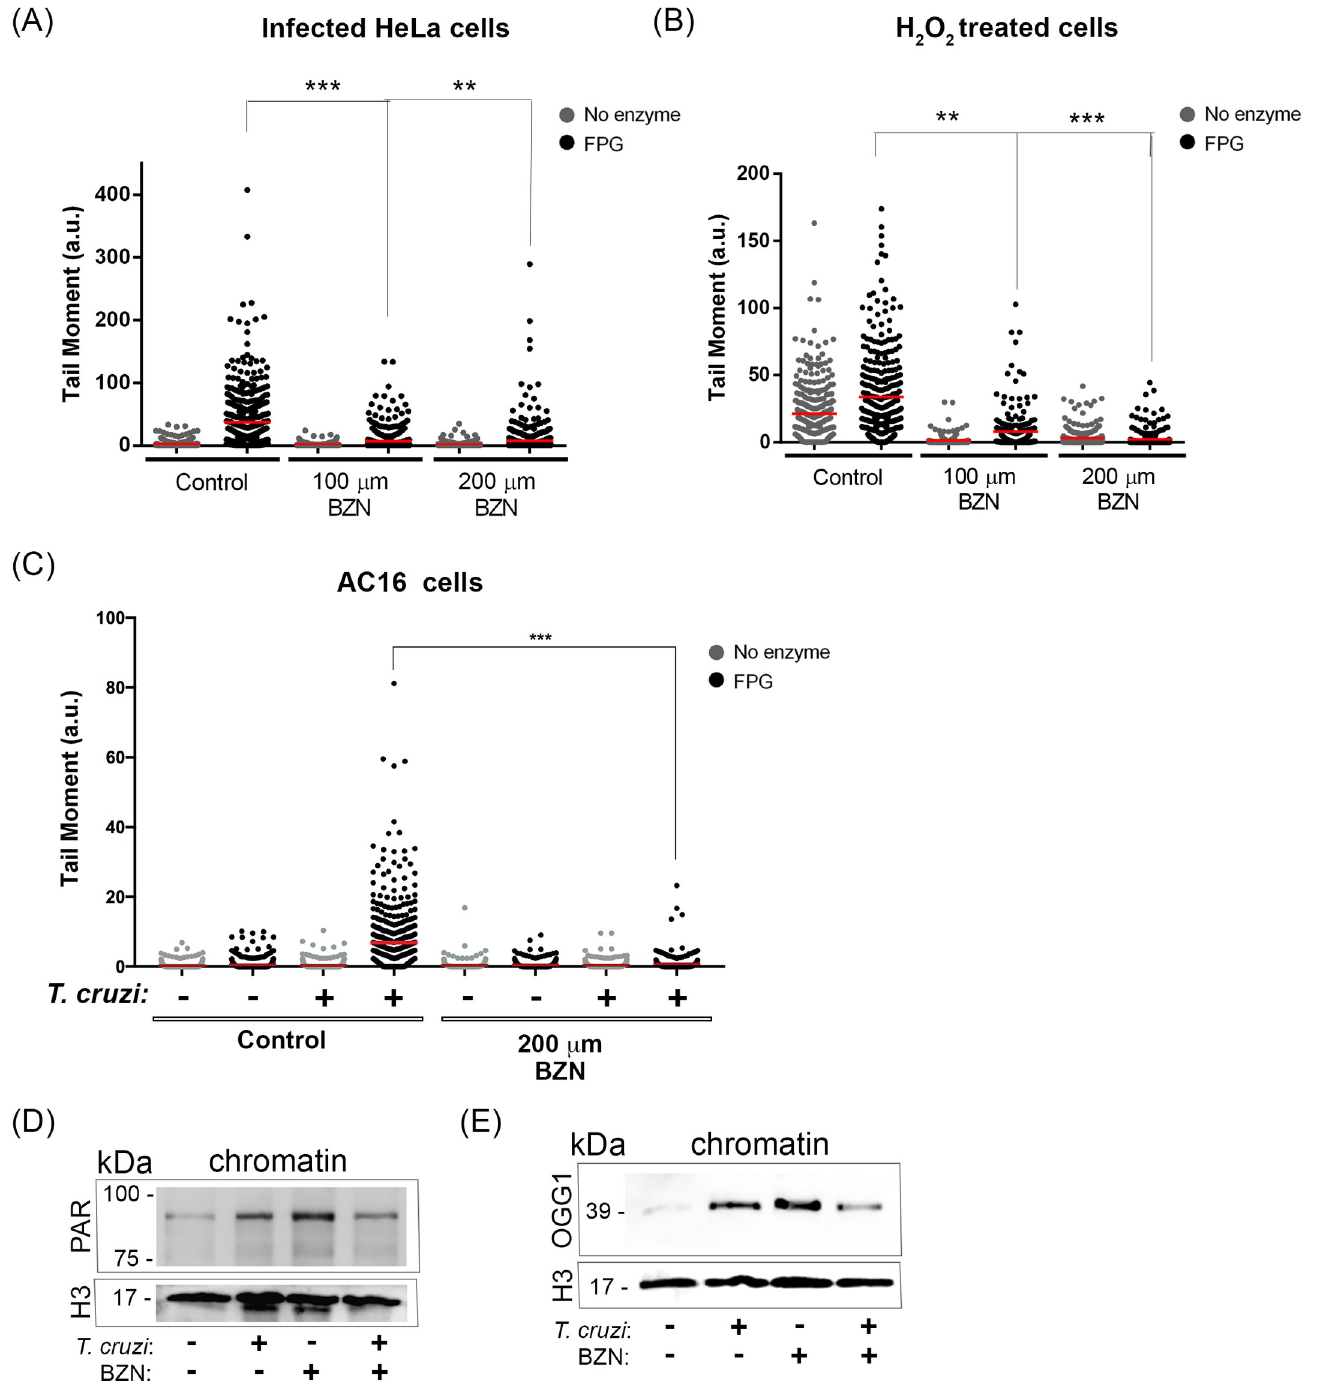
Fig 5. Benznidazole reduces DNA damage developing an adaptive response to HeLa cells. Comet assay was performed in (A) Infected HeLa cells, (B) cells treated with H 2 O 2 (20 μ m), or (C) Infected AC16 cells that were pretreated or not with 100 μ m or 200 μ m Benznidazole (BNZ). Scatter plots from tail moment quantification of 3 independent experiments (100 cells per experiment) were performed. �� p < 0.01; ��� p < 0.001. Isolated chromatin from infected cells or not that were pretreated or not with BNZ (200 μ m) were immunoblotted with (E) anti-PAR (F) anti-OGG1. Histone 3 was used as a loading control.